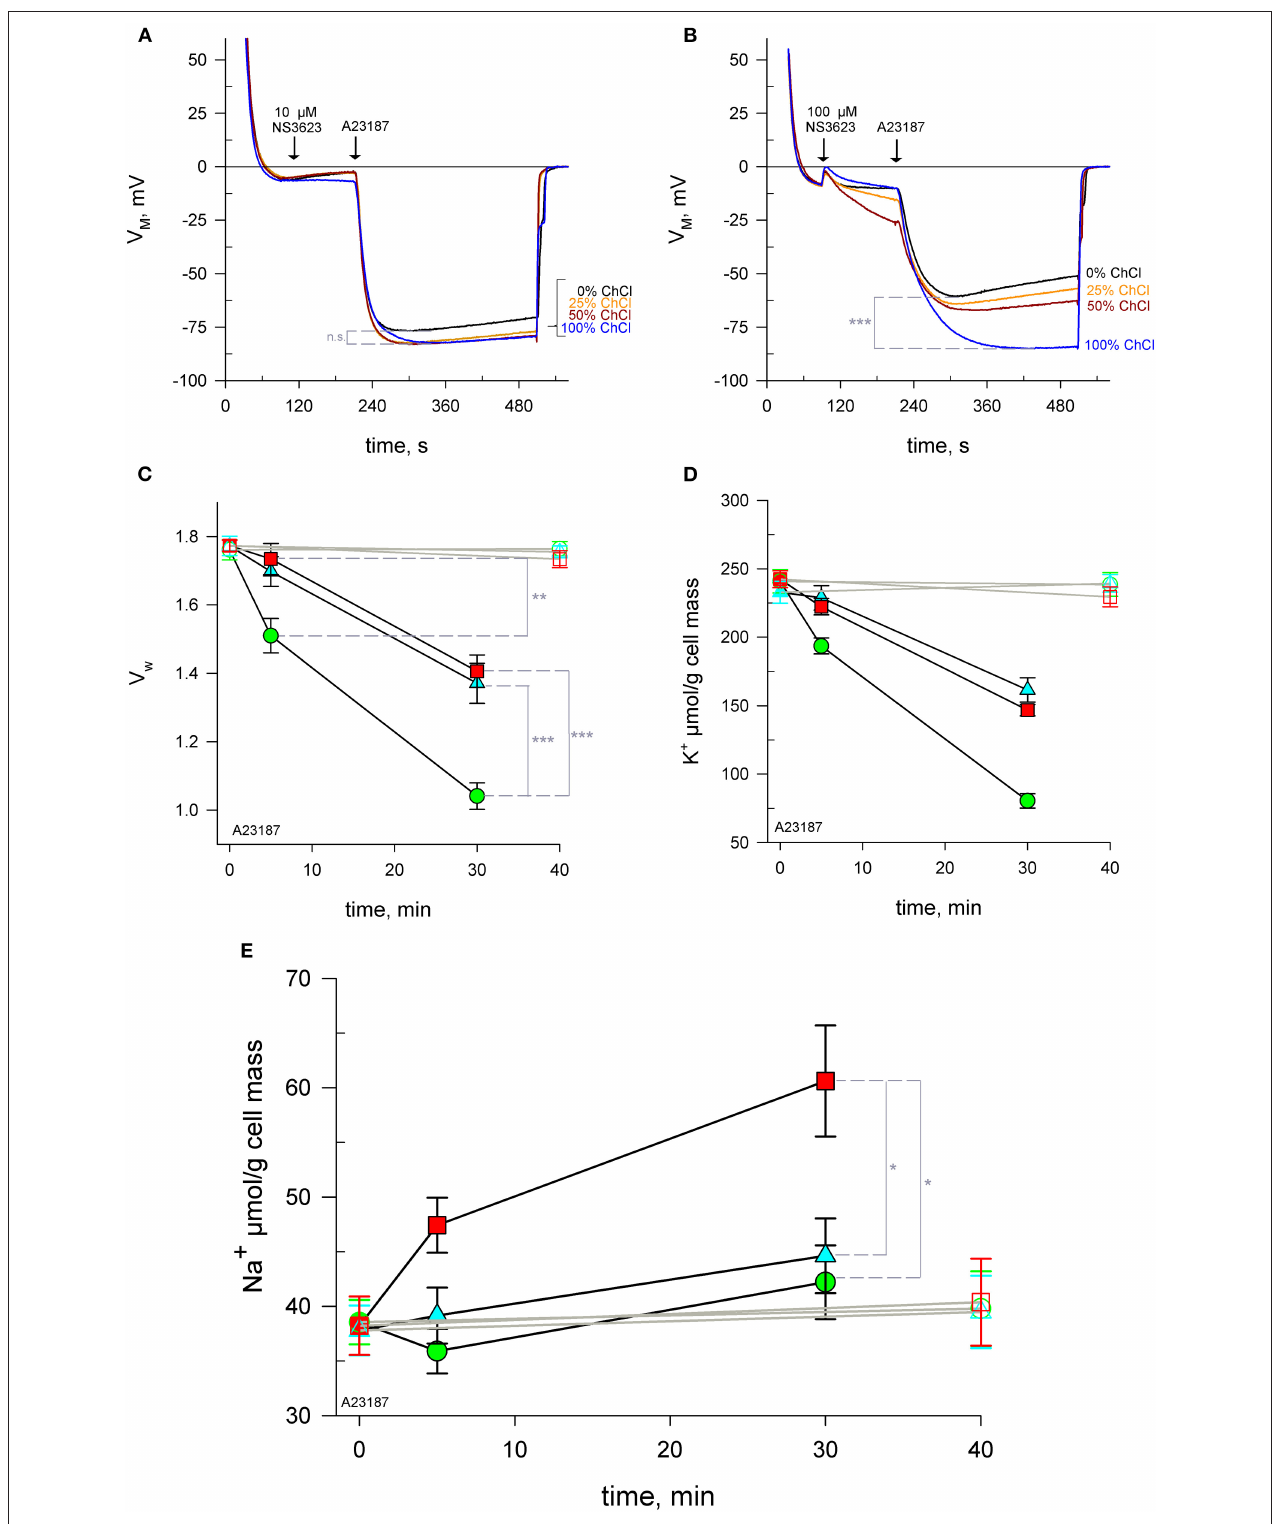
FIGURE 2 | NS3623 becomes a potential NSC activator at high concentrations. (A, B) Evolution of membrane potential from cells injected into respective choline chloride-substituted Ringers (0 to 100% choline), treated with 10 µ M (A), ( n = 3) or 100 µ M (B), ( n = 3) of NS3623 and hyperpolarized with A23187 (10 µ M). Intracellular water content (wet weight/dry weight), (C) and quantity of K + (D) and Na + (E) in packed RBCs washed with normal Ringer buffered with HEPES (pH = 7.4) and treated with 0 (green), 10 (cyan) or 100 µ M (red) of NS3623 and with (closed symbols, black lines) or without (open symbols, gray lines) 10 µ M A23187 over time. Bars denote SEM. Average of five independent experiments. n.s., not significant, * p < 0.05, ** p < 0.01; *** p < 0.001.